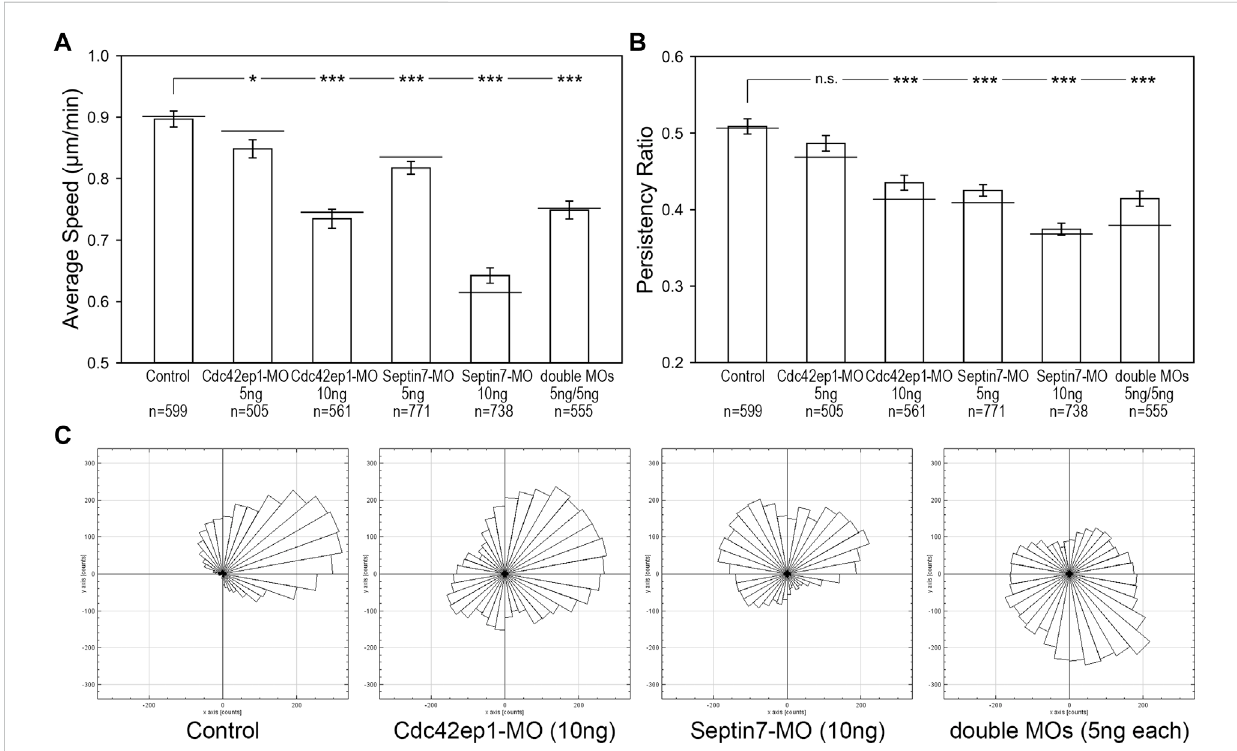
FIGURE 5 Septin fi laments and Cdc42ep1 cooperate in regulating the directional migration of neural crest cells. (A) The effect of Cdc42ep1 knockdown, Septin7knockdown,anddoubleknockdownonthespeedofneuralcrestcellmigration. (B) TheeffectofCdc42ep1knockdown,Septin7knockdown,and doubleknockdownonthepersistenceofneuralcrestcellmigration. — ,median;errorbars,standarderrorofthemean;*, p < 0.05;***, p < 0.001. (C) Rose plots of representative neural crest explants demonstrating the directional migration of neural crest